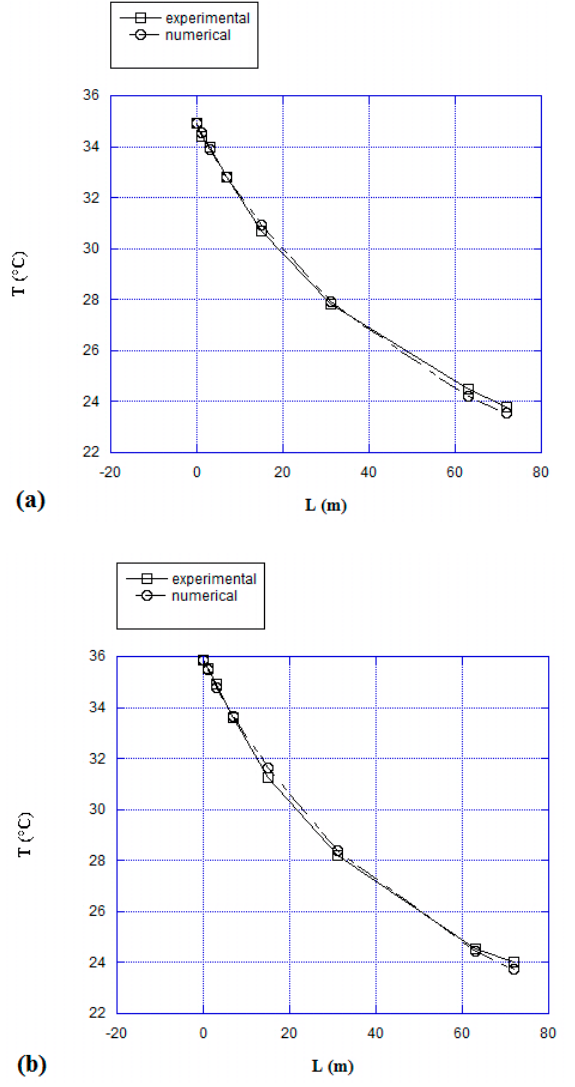
Figure 7. Experimental [49] and numerical results for temperature of the air flowing alongside one pipe of the EAHX at 5 m s − 1 and inlet temperature of ( a ) 34.9 °C and ( b ) 35.9 °C.